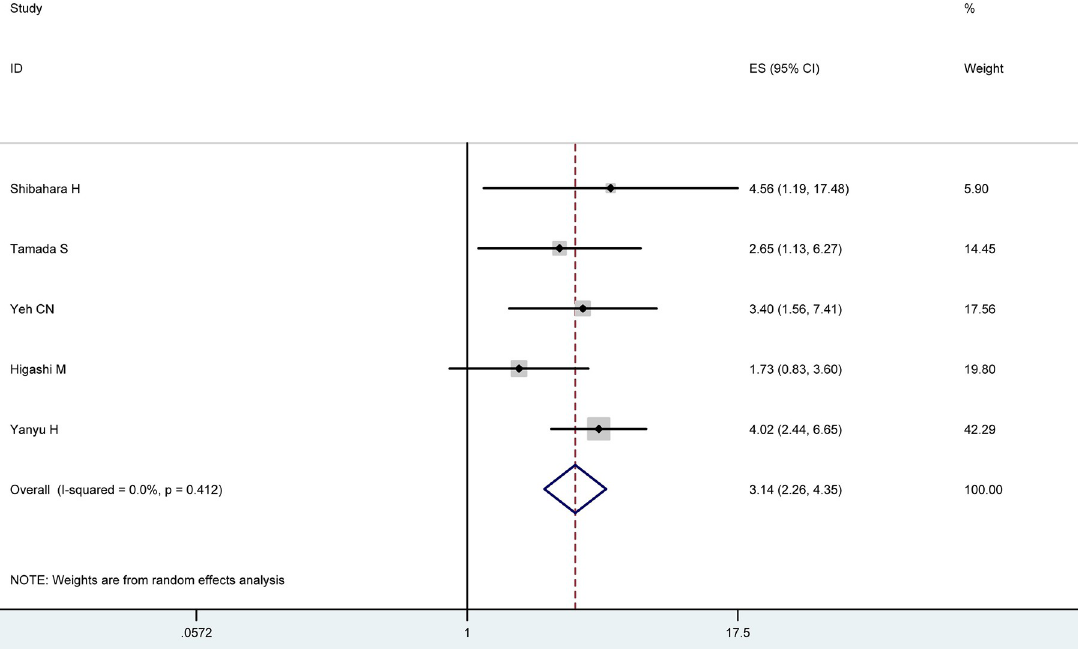
Fig 2. Results of the meta-analysis on pooled HR values. Each square denotes the HR for that trial comparison with the horizontal lines showing the 95% CIs. The size of the square is directly proportional to the amount of information contributed by the trial. The hollow blue diamond gives the pooled HR from the random effect model; the centre of this diamond denotes the HR and the extremities the 95% CI.